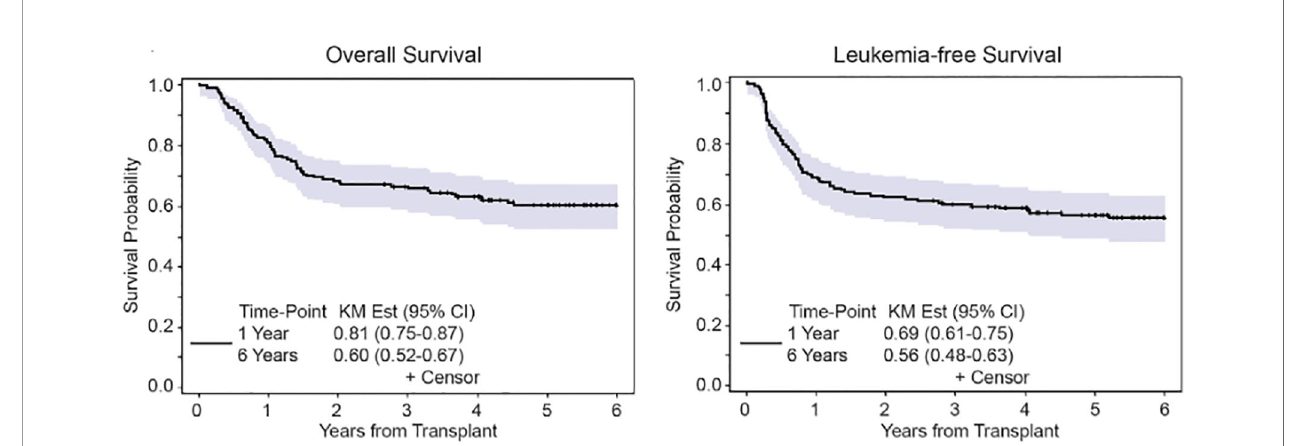
FIGURE 3 | Overall survival and leukemia-free survival after 6 years in AML patients undergoing FTBI